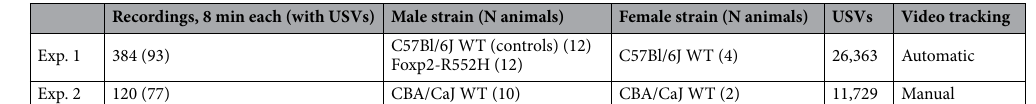
Recordings, 8 min each (with USVs) Male strain (N